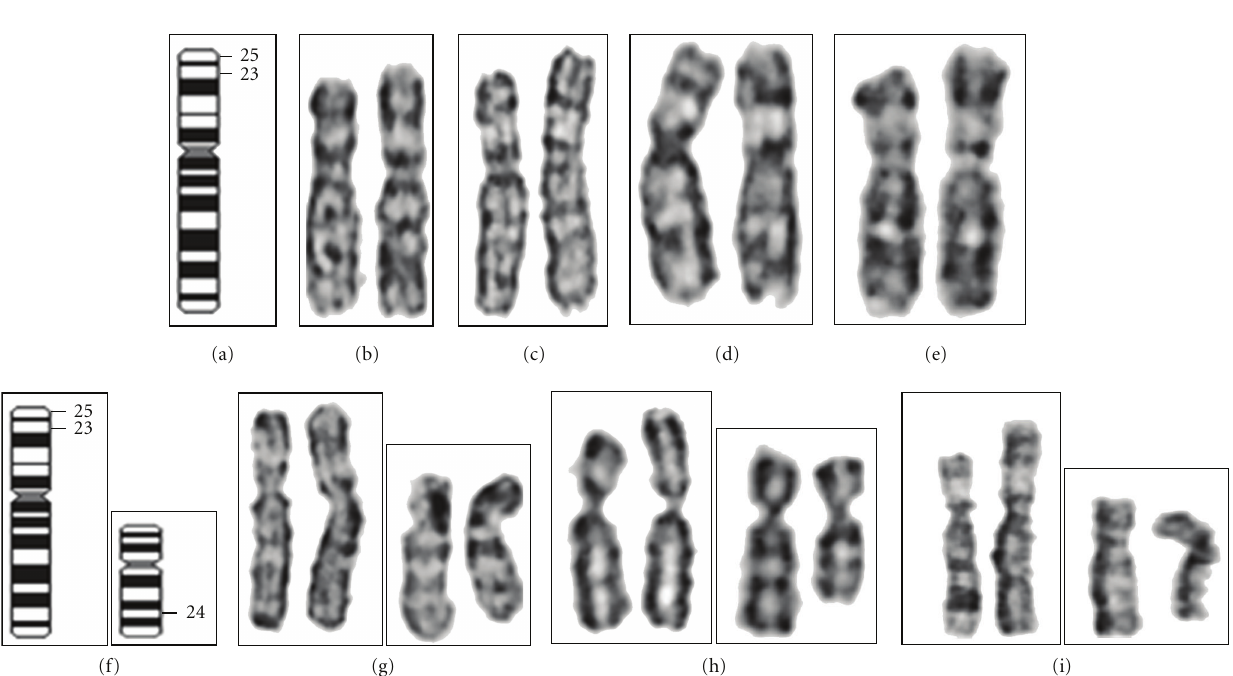
Figure 2: Partial karyotypes. (b)–(e) child, (g)–(i) mother (the normal chromosome is placed in left). Ideogram of chromosome 6 (L) and 10